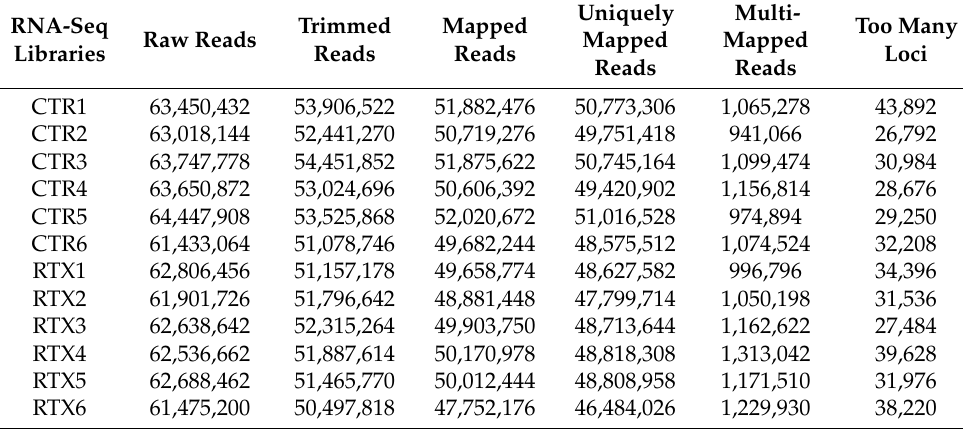
Table 1. Summary of statistical metrics for the RNA-Seq libraries; CTR refers to control samples; RTX refers to the biological replicates of the experimental (RTX-treated) urinary bladder wall samples; “Raw reads“ refers to the number of reads obtained from sequencing protocol; “Trimmed reads” refers to reads that passed the quality control procedure; “Mapped reads” refers to all reads aligned to the reference genome; “Uniquely mapped reads” refers to reads that were mapped to a unique (only one) location of the reference genome; “Multimapped reads” refers to reads aligned to more than one locus on the reference genome; “Reads mapped with too many loci” refers to the reads mapped more than 20 multiple loci on the reference